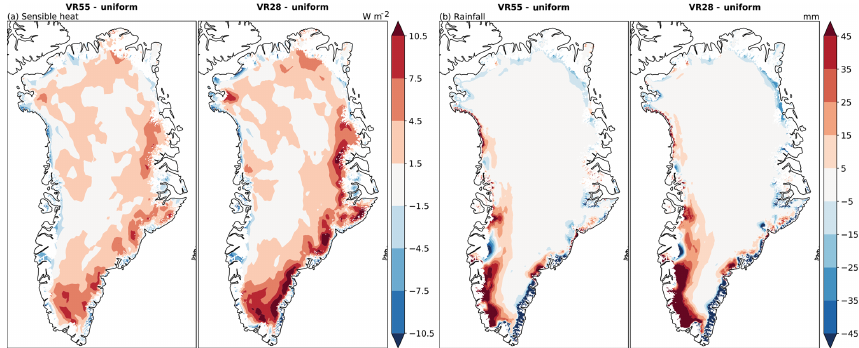
Figure 10. Summer (JJA) anomalies of (a) CLM sensible heat and (b) CLM rainfall over glaciated land units, after downscaling, relative to the coarse-resolution reference simulation (Uniform CESM) over the period 1980–1999. Data have been downscaled to 4km using EC